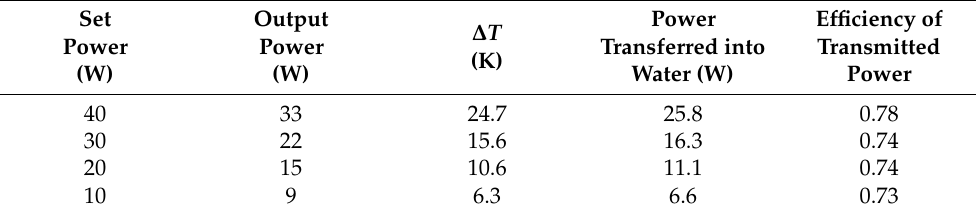
Table 2. The set power, measured output power and the difference between the inlet and maximal outlet temperature of the water. The calculated power transferred into water and the efficiency of the power transmitted into the water.